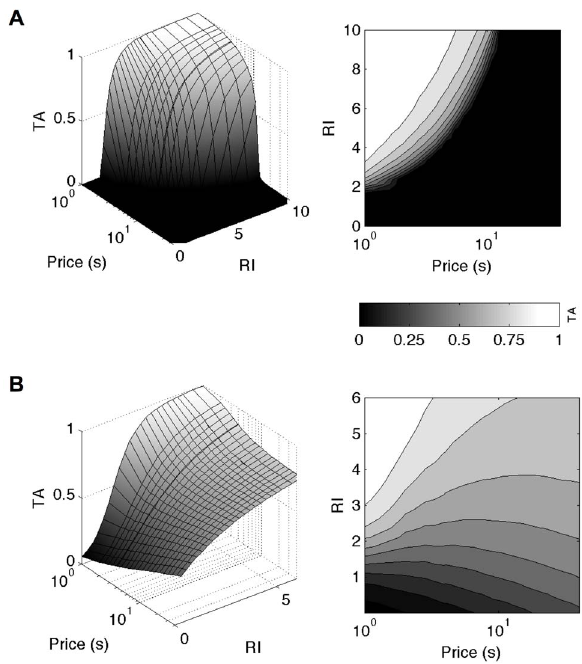
Figure 6. Macroscopic time allocation derived from normative, microscopic choices yields a superset of the mountain model. Left panels: 3-dimensional relationships between TA , reward intensity and price, right panel: contours of equal TA , predicted by the micro SMDP model for A) linear, B) concave C L ( : ) . The 3-dimensional relationship and smooth contours for a linear C L ( : ) derive the mountain model in Fig.3. Note that an extra, higher set of reward intensities was necessary to achieve the full range of time allocation for linear C L ( : ) . The fact that contours change direction at longer prices for a non-linear C L ( : ) rather than decrease monotonically reflects that TA may no longer decrease and even increase as the price is increased